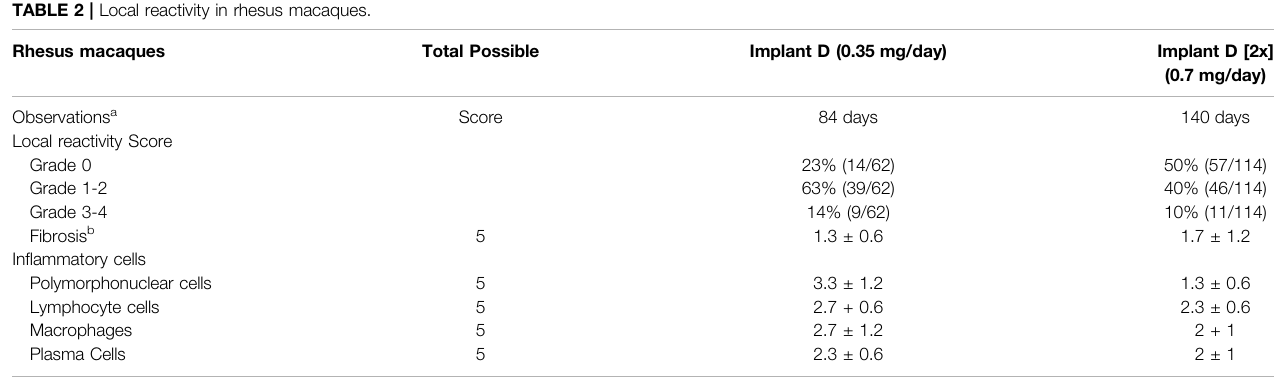
TABLE 2 | Local reactivity in rhesus